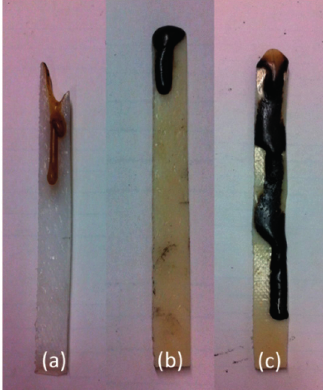
Figure 4. PA6 sample tested at an Oxygen Index (OI) below 28 vol% ( a ); the PA6/GAS 2.5%/MPP 2.5% sample tested at OI between 23 and 30 vol% ( b ) and between 31 and 36 vol% ( c